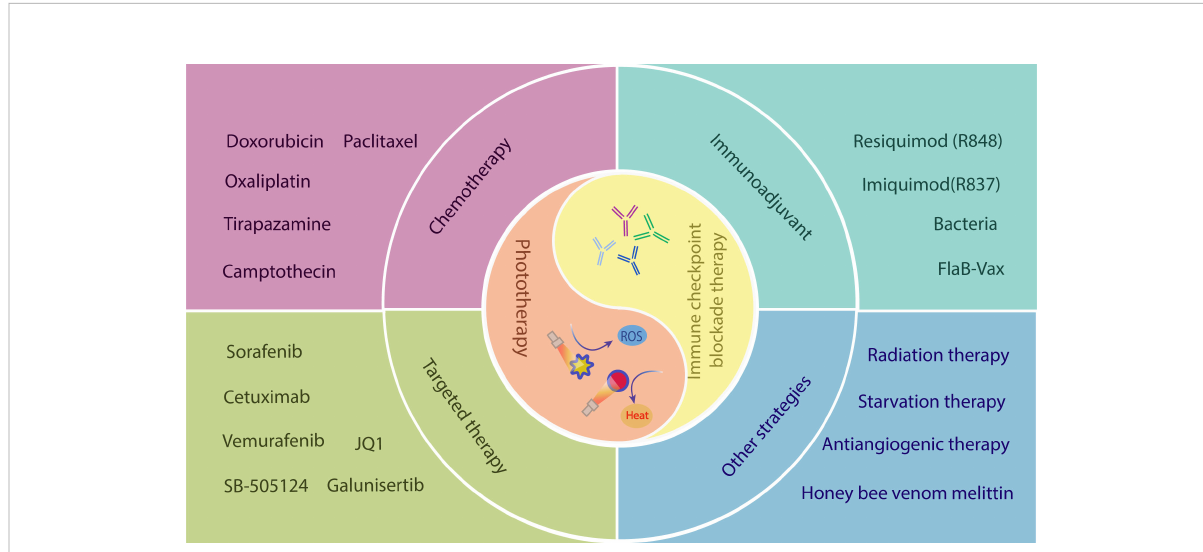
FIGURE 3 PTT/PDT combined with other treatment strategies to improve ICB therapy. PTT and PDT could be combined with different therapeutic modalities, including targeted therapy, chemotherapy, immune adjuvant therapy, starvation therapy, and antiangiogenic therapy to improve the antitumor immune response of ICB and inhibit tumor growth, metastasis, and